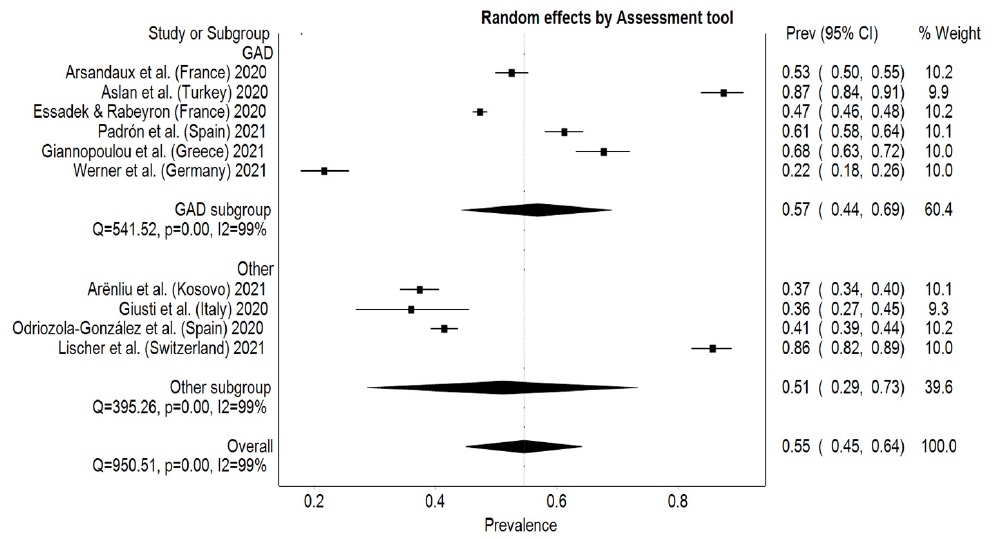
Figure 3. Subgroup analysis between GAD and other anxiety questionnaires. Figure 3 . Subgroup analysis between GAD and other anxiety questionnaires .